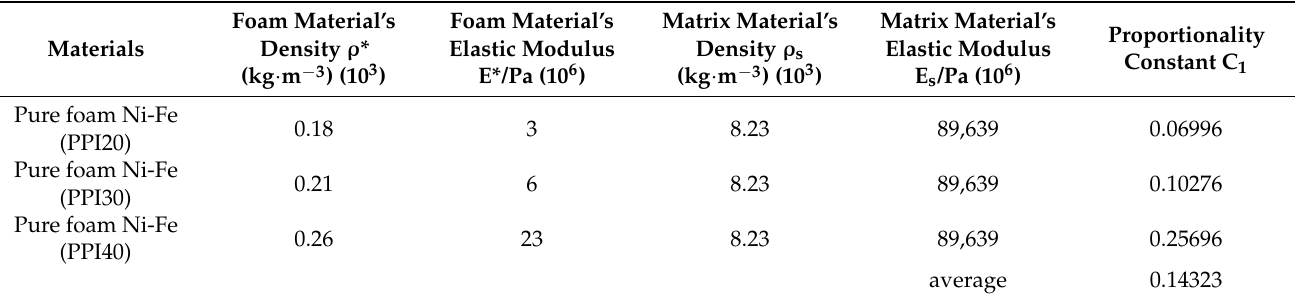
Table 1. C 1 of the foam nickel-iron